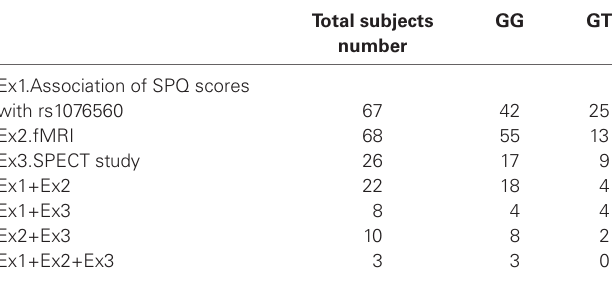
Table 2 | Number of subjects that participated in multiple experiments and genotype distribution